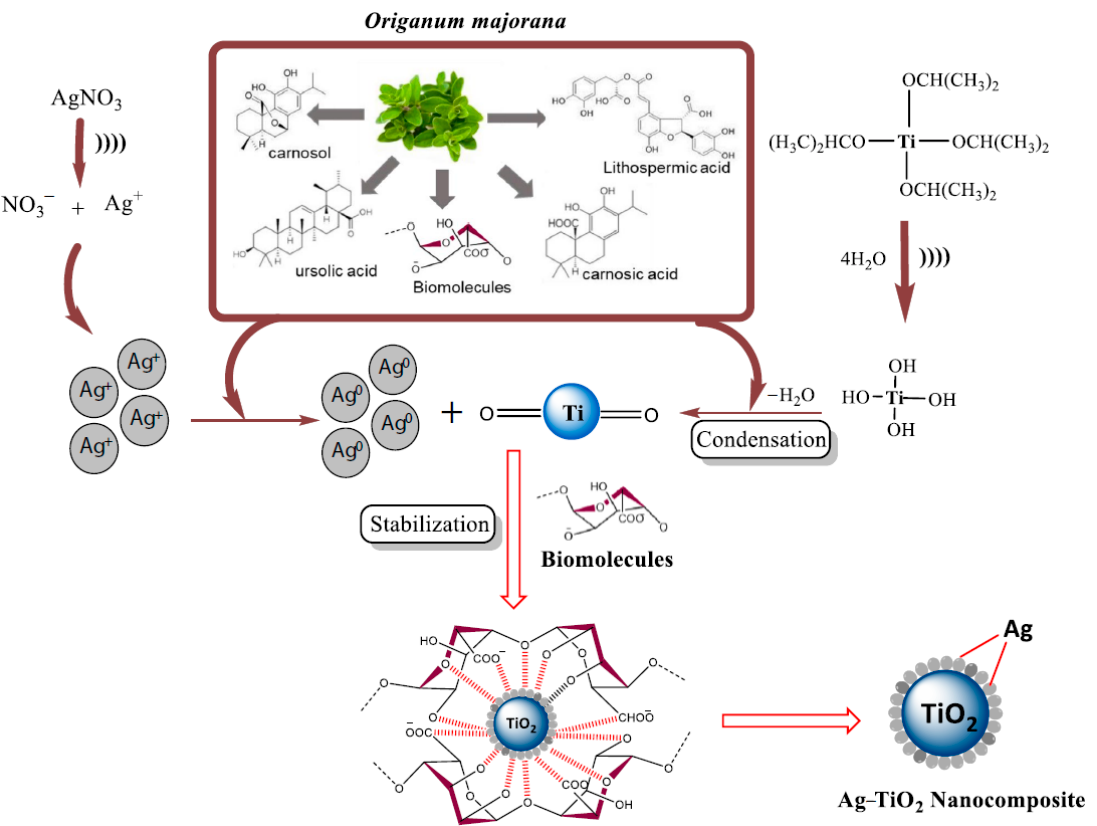
Figure 13. Plausible mechanism for the formation of Ag–TiO 2 NCs using Origanum majorana leaf extract. (Reprinted from [40], license CC BY 4.0.)